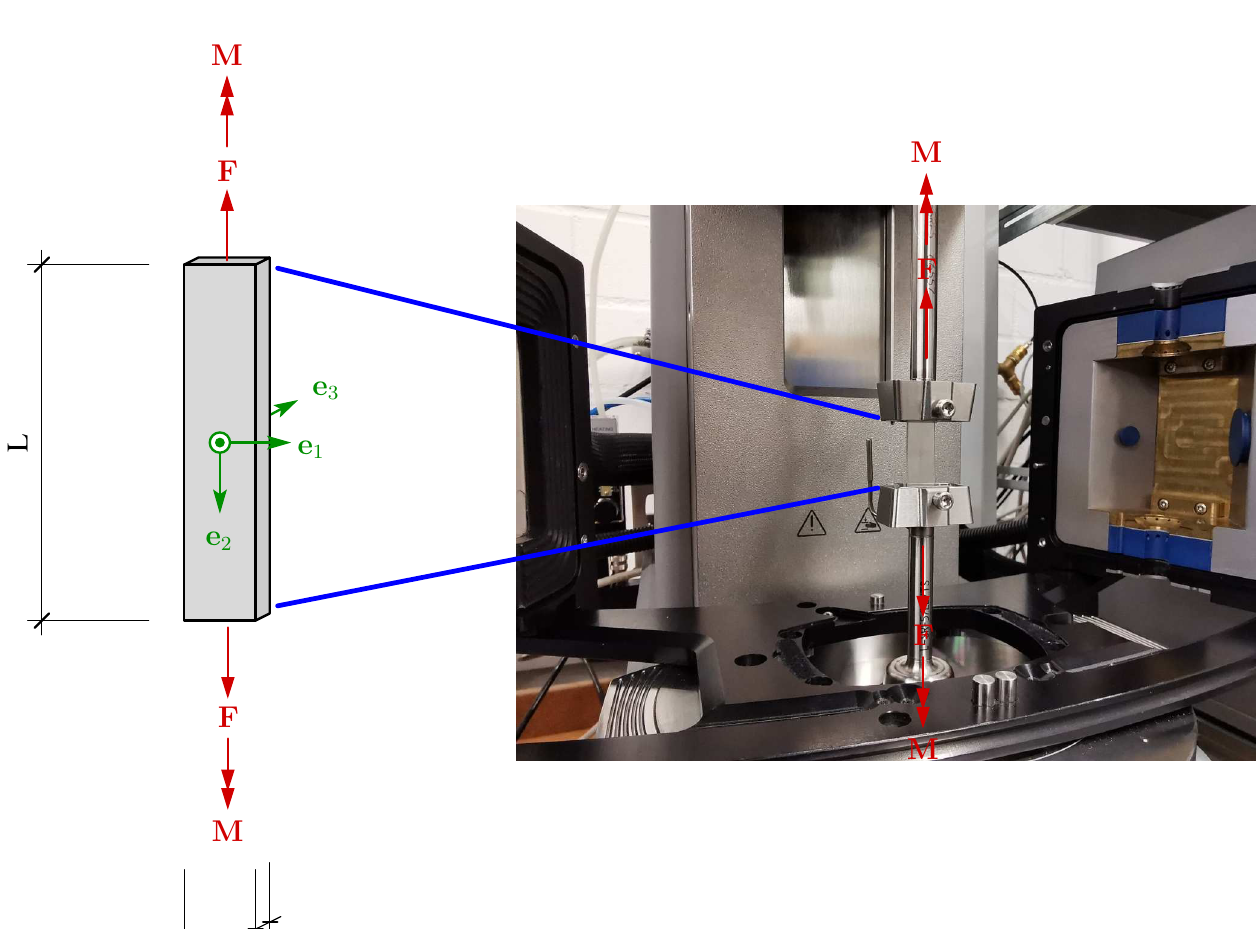
Figure 2. Experimental set-up for torsional loading (torque M) and investigated rectangular SM sample for thermo- rheological